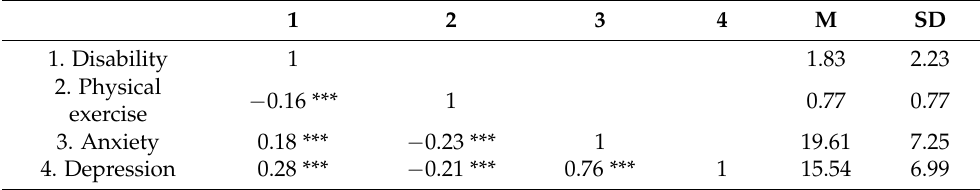
Table 1. Correlations between disability, physical exercise, and mental